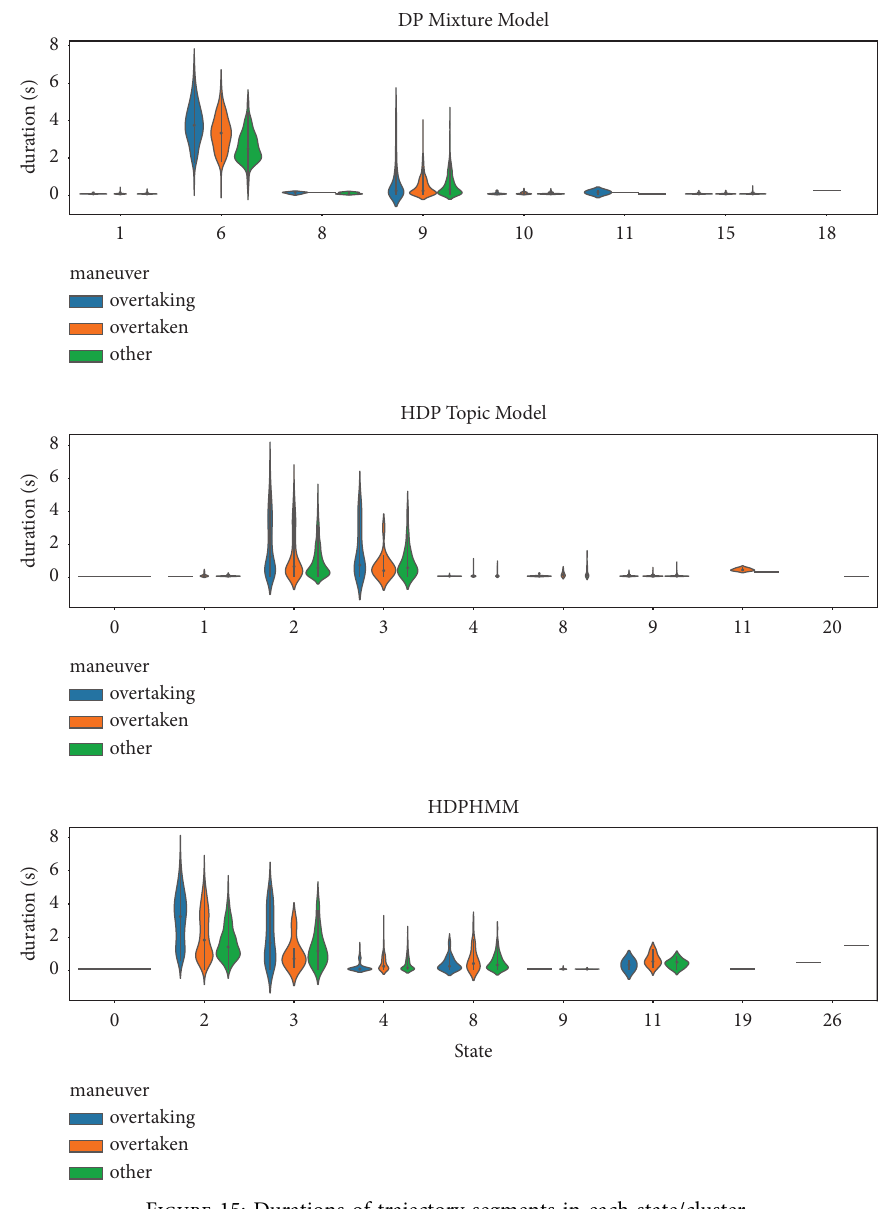
Figure 15: Durations of trajectory segments in each